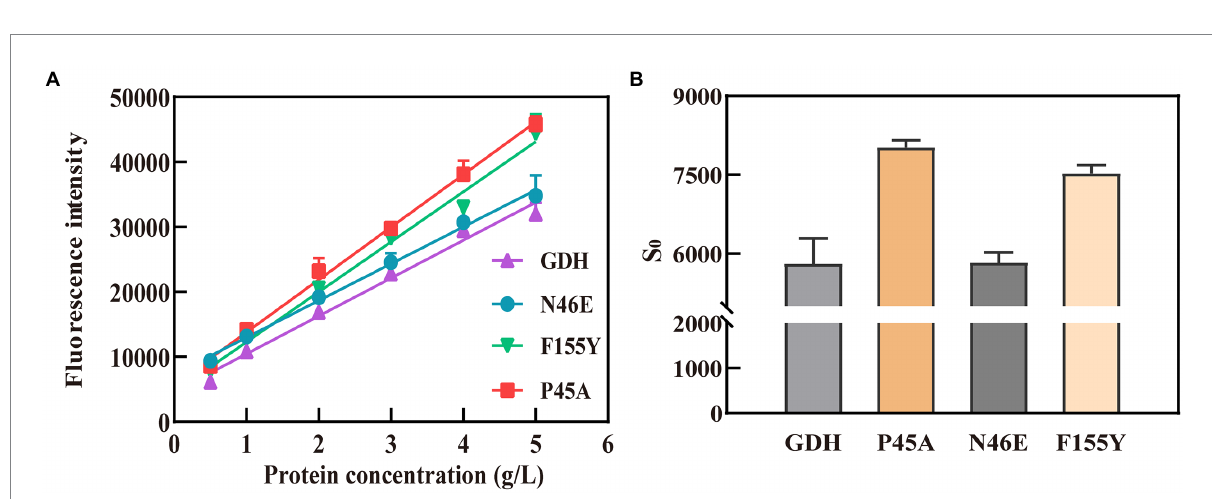
FIGURE 4 Hydrophobicity analysis of GDH mutants by ANS fluorescent probe. (A) Fitting curves for GDH mutants. The fluorescence intensity ( λ ex 390 nm and λ em 504 nm) of the GDH variants was analyzed and fitted linearly. (B) Hydrophobicity index (S 0 ) of GDH mutants. The curve slope was used as an index of protein hydrophobicity (S0). The results are expressed as the mean ± SD ( n =